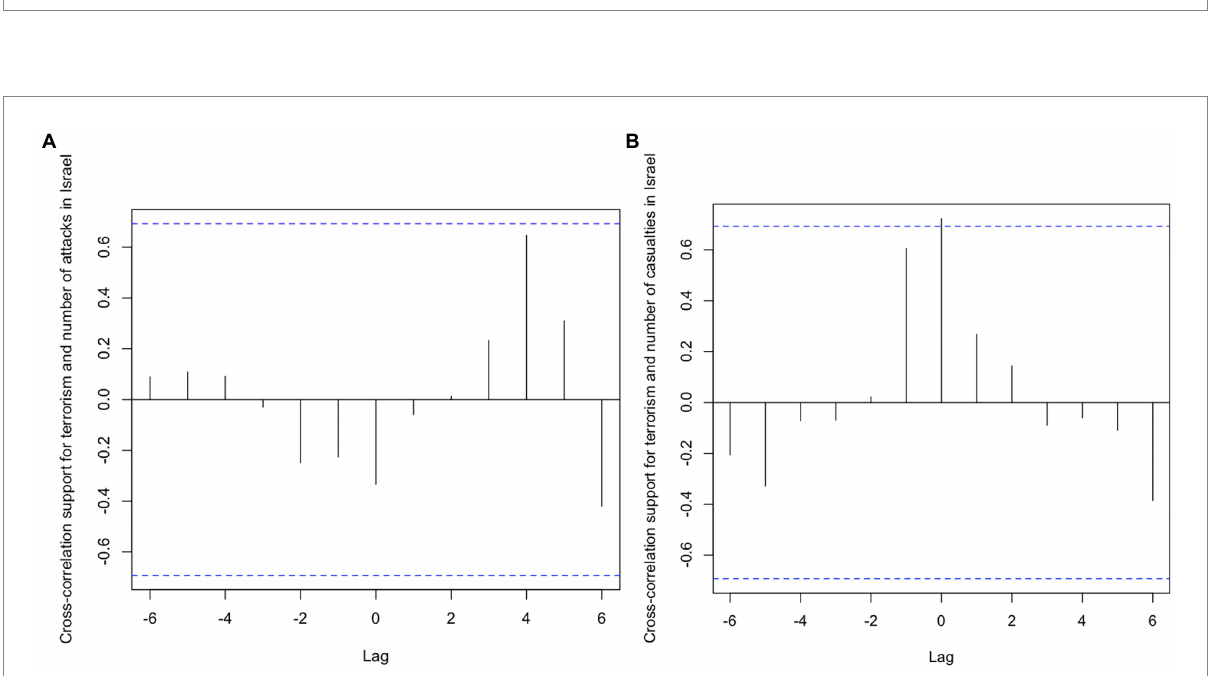
FIGURE 7 Cross-correlation function of time-series “Terrorism is ever justified” and “Number of attacks” Panel (A) as well as “Casualties in Israel” Panel (B)